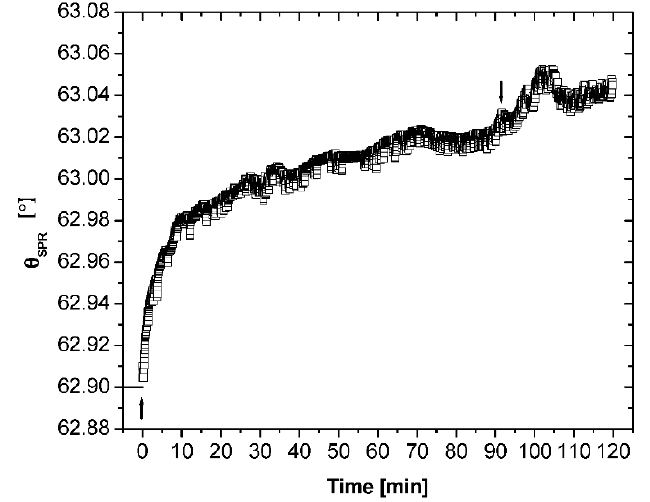
Figure 7. Real-time kinetic θ SPR scans on the buildup of a Boron cage [B 12 H 11 SH] 2 − . self-assembled monolayer by SPR, using laminar flow.